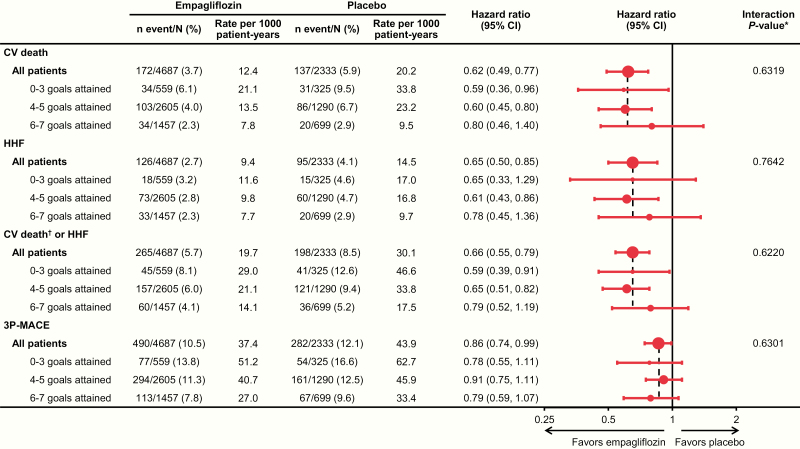
Effect of empagliflozin versus placebo on CV outcomes across subgroups of achievement of CV risk factor goals at baseline: HbA1c <7.5%; LDL cholesterol <100 mg/dL or statin use; SBP <140 mmHg and DBP <90 mmHg; use of ACE inhibitor or ARB; normoalbuminuria; aspirin use; and/or nonsmoking. Cox regression analysis in patients treated with ≥1 dose of the study drug. Data on attainment of CV risk factor goals at baseline were unavailable for 85 patients (66 empagliflozin and 19 placebo). 3P-MACE indicates 3-point major adverse CV events (CV death, nonfatal myocardial infarction, or nonfatal stroke). Abbreviations: ACE, angiotensin-converting enzyme; ARB, angiotensin II receptor blocker; CI, confidence interval; CV, cardiovascular; DBP, diastolic blood pressure; HbA1c, glycated hemoglobin; HHF, hospitalization for heart failure; LDL, low-density lipoprotein; SBP, systolic blood pressure. *P-value relates to test of homogeneity of treatment group differences among subgroups (test for treatment by subgroup interaction) without adjustment for multiple testing. †Excludes fatal stroke.